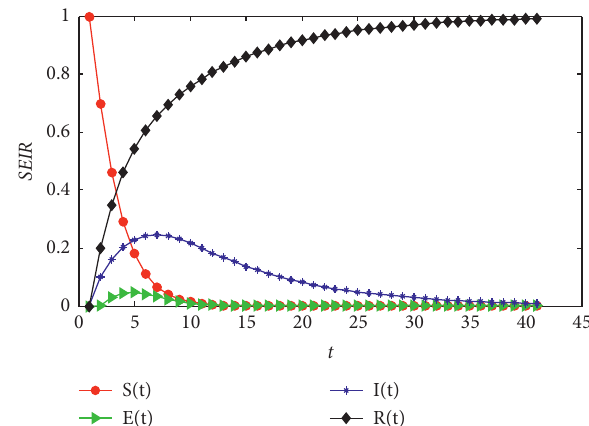
Figure 9: Change trend of SEIR model (4) (when μ 1 � 0.4, μ 2 � 0.1, μ 3 � 0.2, α � 0.4 and c � 0.1, the change of four independent states of the credit subject trend over time).